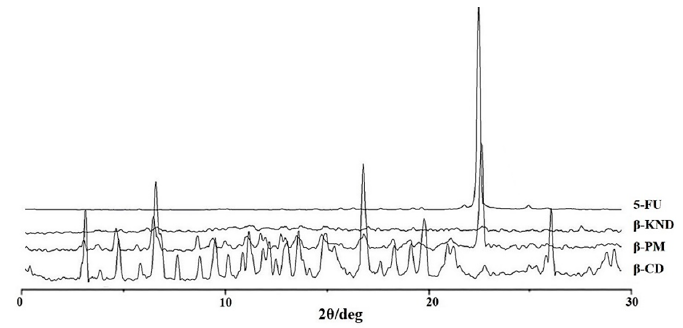
Figure 7. The powder XRD patterns of 5-FU, β -KND, β -PM, and β -CD.